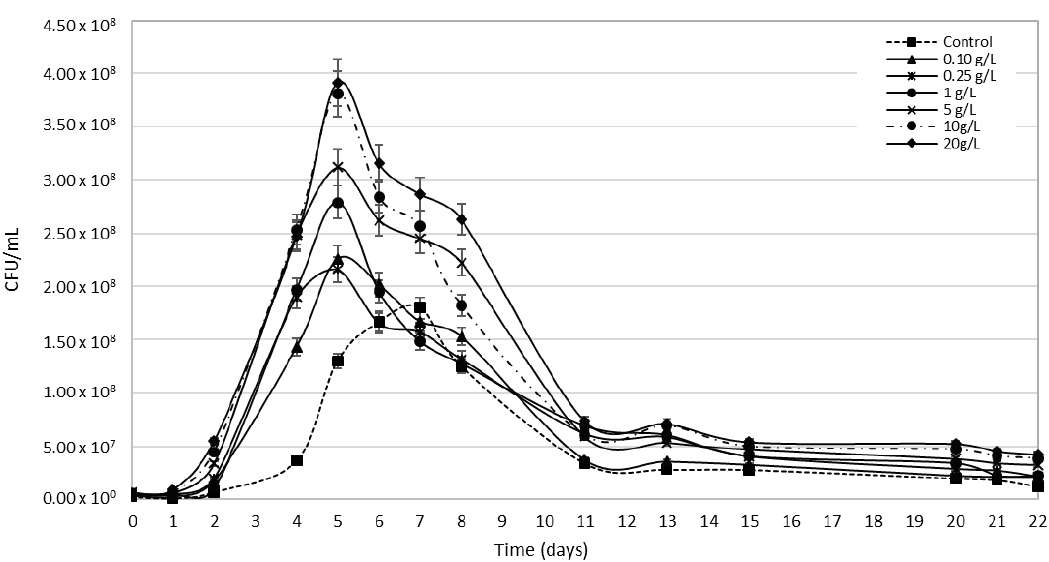
Figure 3. Development of viable biomass of Saccharomyces cerevisiae yeast during the process of alcoholic fermentation of the Tintilla de Rota-must using different doses of bee pollen and control. CFU: colony forming unit.